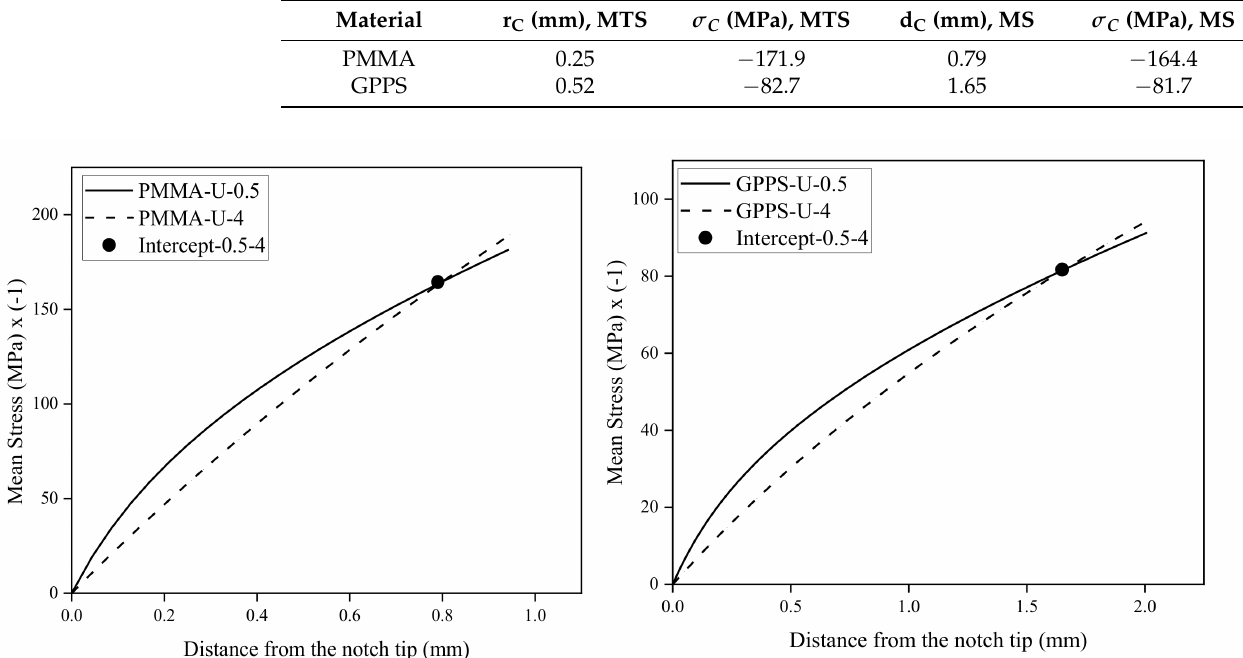
Figure 9. Compressive mean stress–distance curves at fracture for PMMA and GPPS